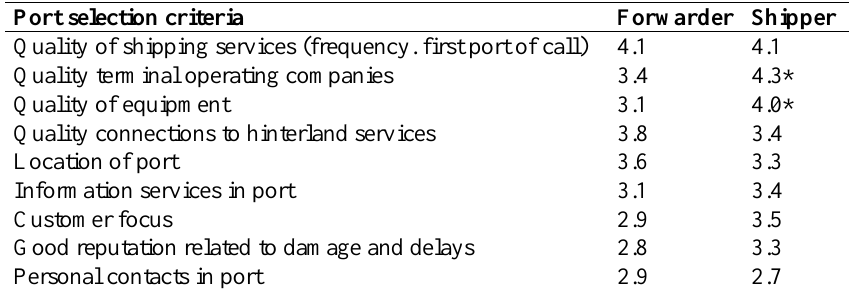
Table 4. Average means of various port selection criteria for shippers and